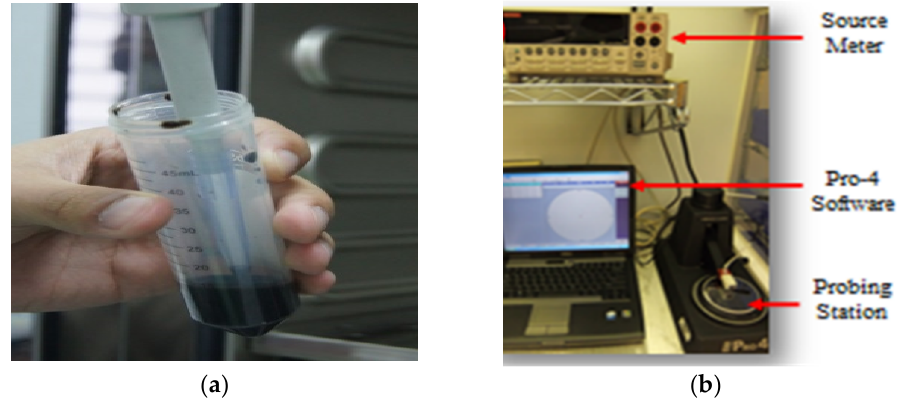
Figure 5. ( a ) Liquid reduced graphene oxide ( b ) Four-point probe device.